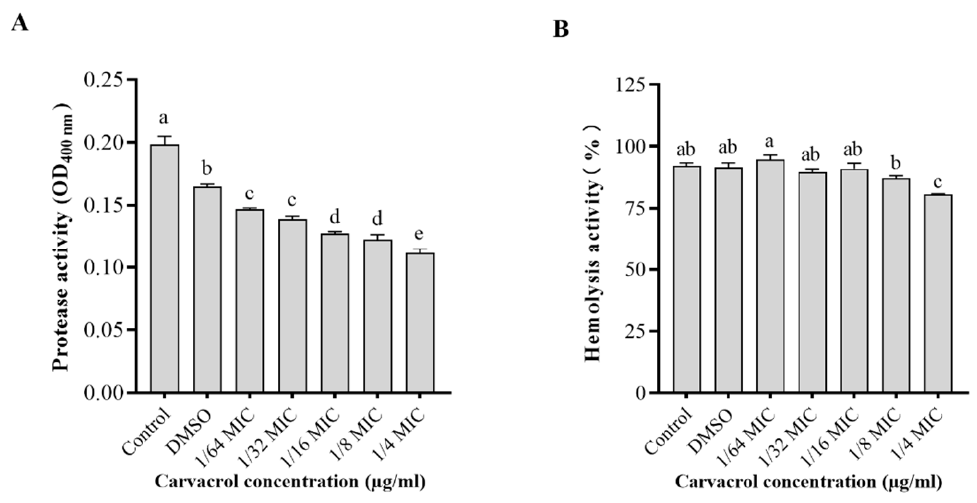
Figure 3. Effect of carvacrol on protease ( A ) and hemolysis ( B ) activities in A. hydrophila . Data are presented as the mean ± standard error (SE) of three independent experiments. The results were analyzed with one-way ANOVA using Tukey’s multiple comparison posttest. a–e: Values with different letters are significantly different ( p < 0.05), while those with similar letters are not.